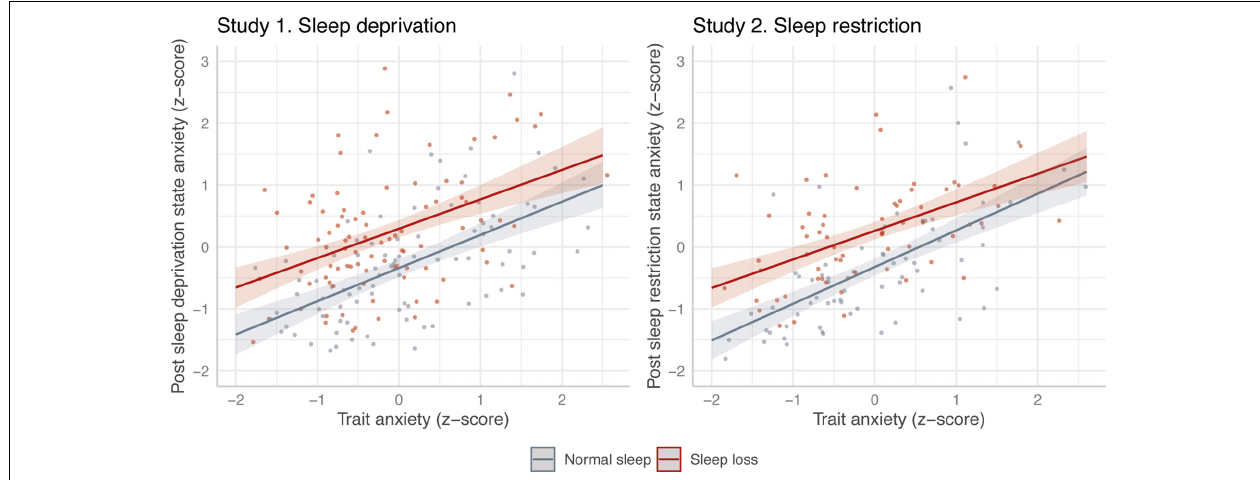
FIGURE 1 | Association between trait anxiety and state anxiety reported before (gray) and after (red) sleep loss. The left-hand graph represents the results from study 1, using between-subjects sleep deprivation. The right-hand graph represents the results from study 2, using within-subjects sleep restriction. Model predictions are based on the models in Table 2 . Solid line represents estimated association, with 95% credible intervals. Dots represent raw data points (jittered).